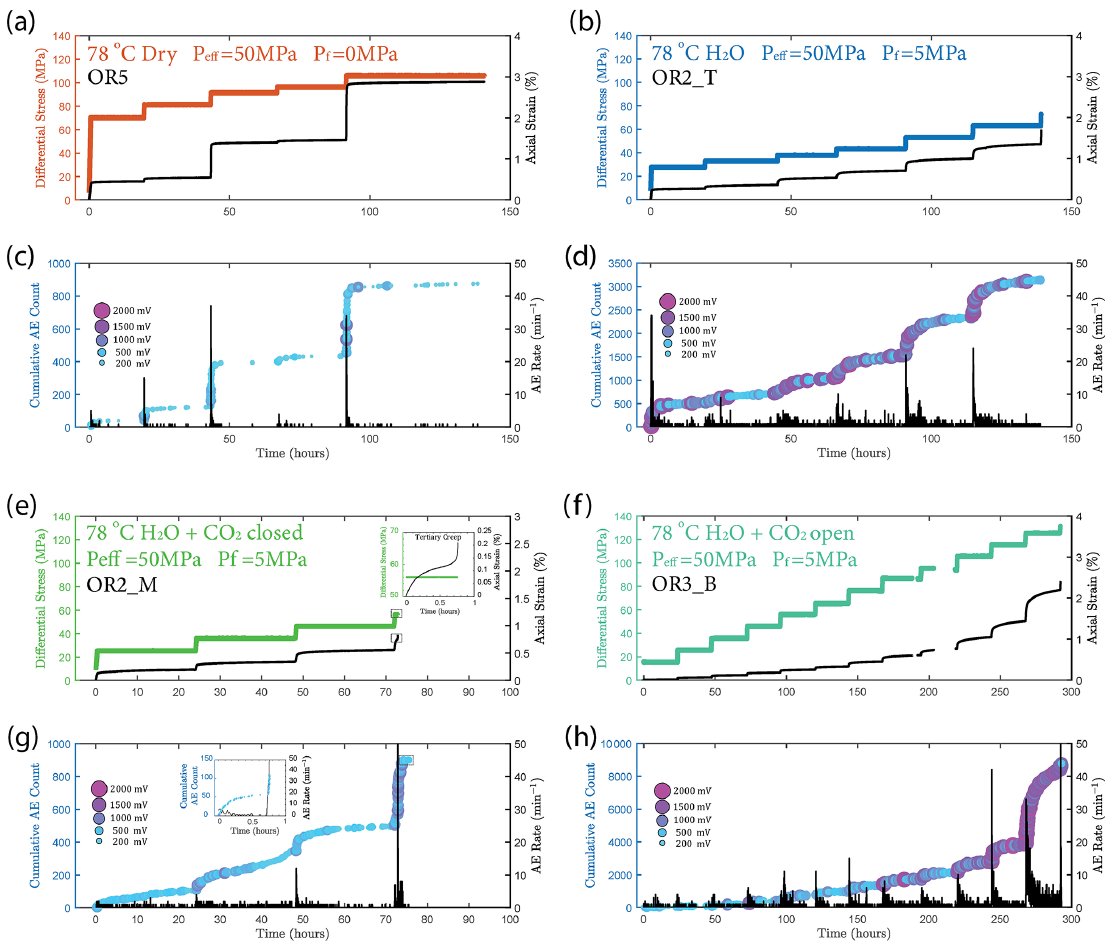
Figure 7. (a, b, e, f) Plot of stress loading steps and strain (black) evolution. (c, d, g, h) Evolution of cumulative number of acoustic emission (AE) and AE rate evolution (black) over time for (a, c) dry, (b, d) H 2 O, e.g. H 2 O + CO 2 closed (note the short tertiary creep stage accompanied by a burst of AE activities during the last stress step; see insets) and (f, h) H 2 O + CO 2 open